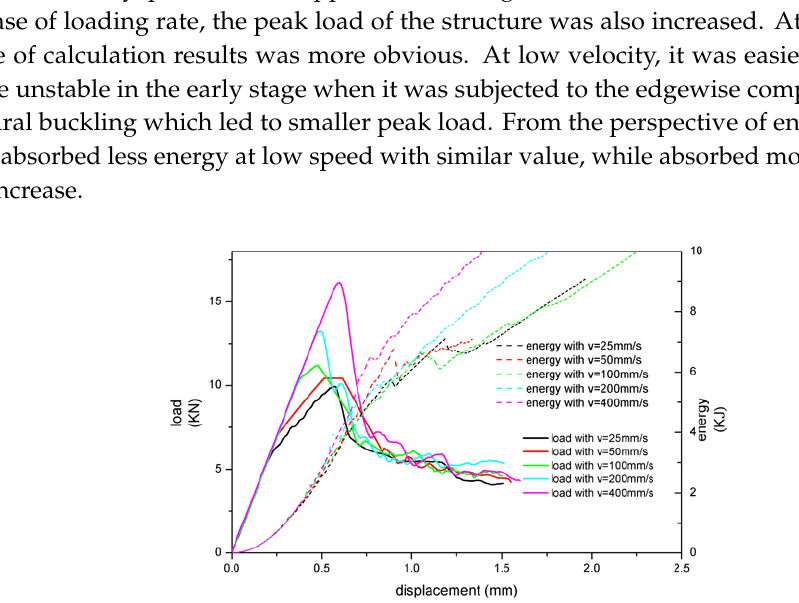
Figure 5. The relationship between load, energy absorption, and displacement with MAT 185.